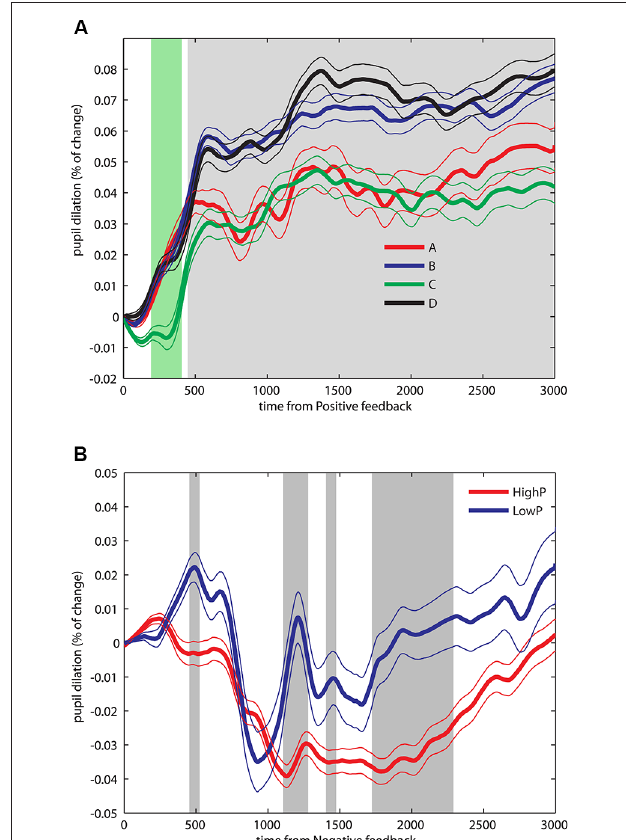
FIGURE 2 | Pupil dilation dynamics during an IGT. (A) Pupil dilation dynamics during PF. An ANOVA performed over successive data points over the whole PF period, yielded a main effect for NF magnitude during a brief period after positive reward presentation (200–400 ms, green shaded area) as well as a main effect for NF probability for a sustained period starting at 500 ms until the end of the period (gray shaded area). (B) Pupil dilation dynamics during NF. Data from four decks were pooled by NF probability in HighP decks (A and C), and LowP decks (B and D). Significant differences were found during a brief period around 500 ms, and in two later sustained periods ranging from 1200–1300 and 1700–2400 ms. Significant results are reported after FDR correction, p FDR < 0.05. Data depicted as Mean + / − SEM.